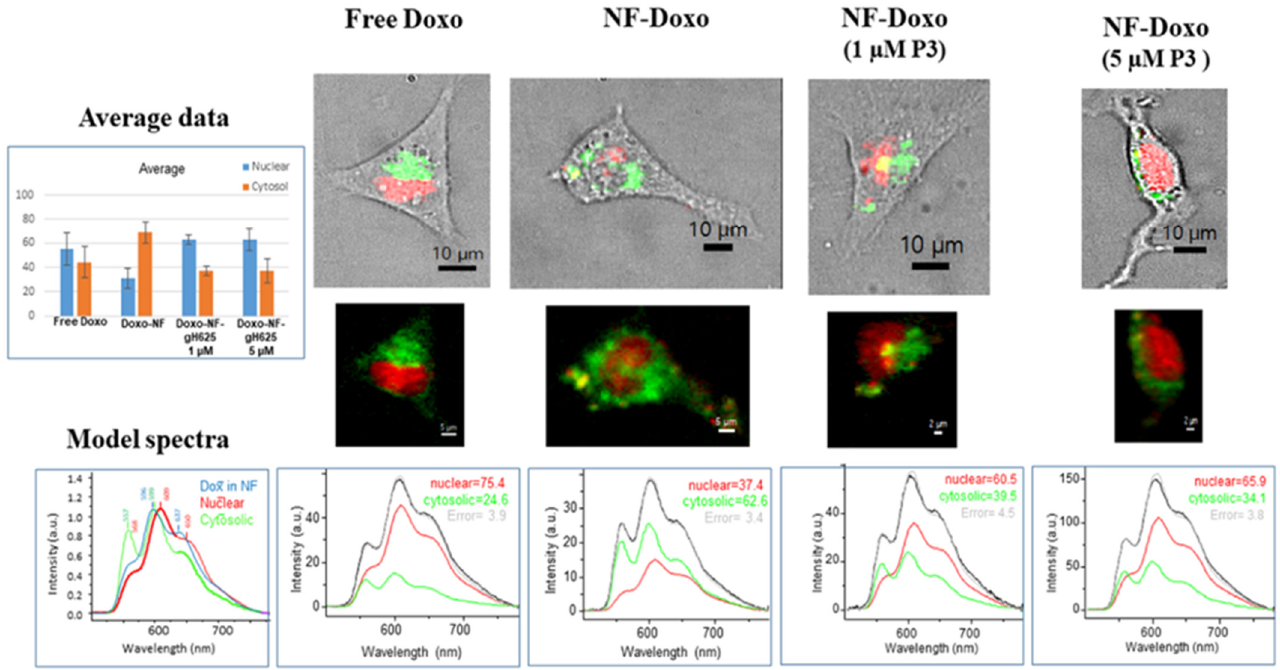
Figure 9. Results of fluorescence confocal spectral imaging on MDA-MB-231 cells treated for 1 h with 5 M solution of free Doxo in solution and with NF-Doxo , decorated with 1 or 5 μM of P3 or void of P3 . Left top window: summarized statistical data on the two fractions of intracellular fluorescence: nuclear (red) and cytosolic (green). Top panels: typical spectral maps and their overlay with video images of the cells. Bottom panels: Window on the left side: model spectra of fluorescence–Doxo in NF-Doxo (blue); Doxo in nuclear zones (red); Doxo in cytosolic zones (green). Middle and right-side windows: average spectra of the cell shown above deconvoluted into the two model spectra (cytosolic and nuclear).